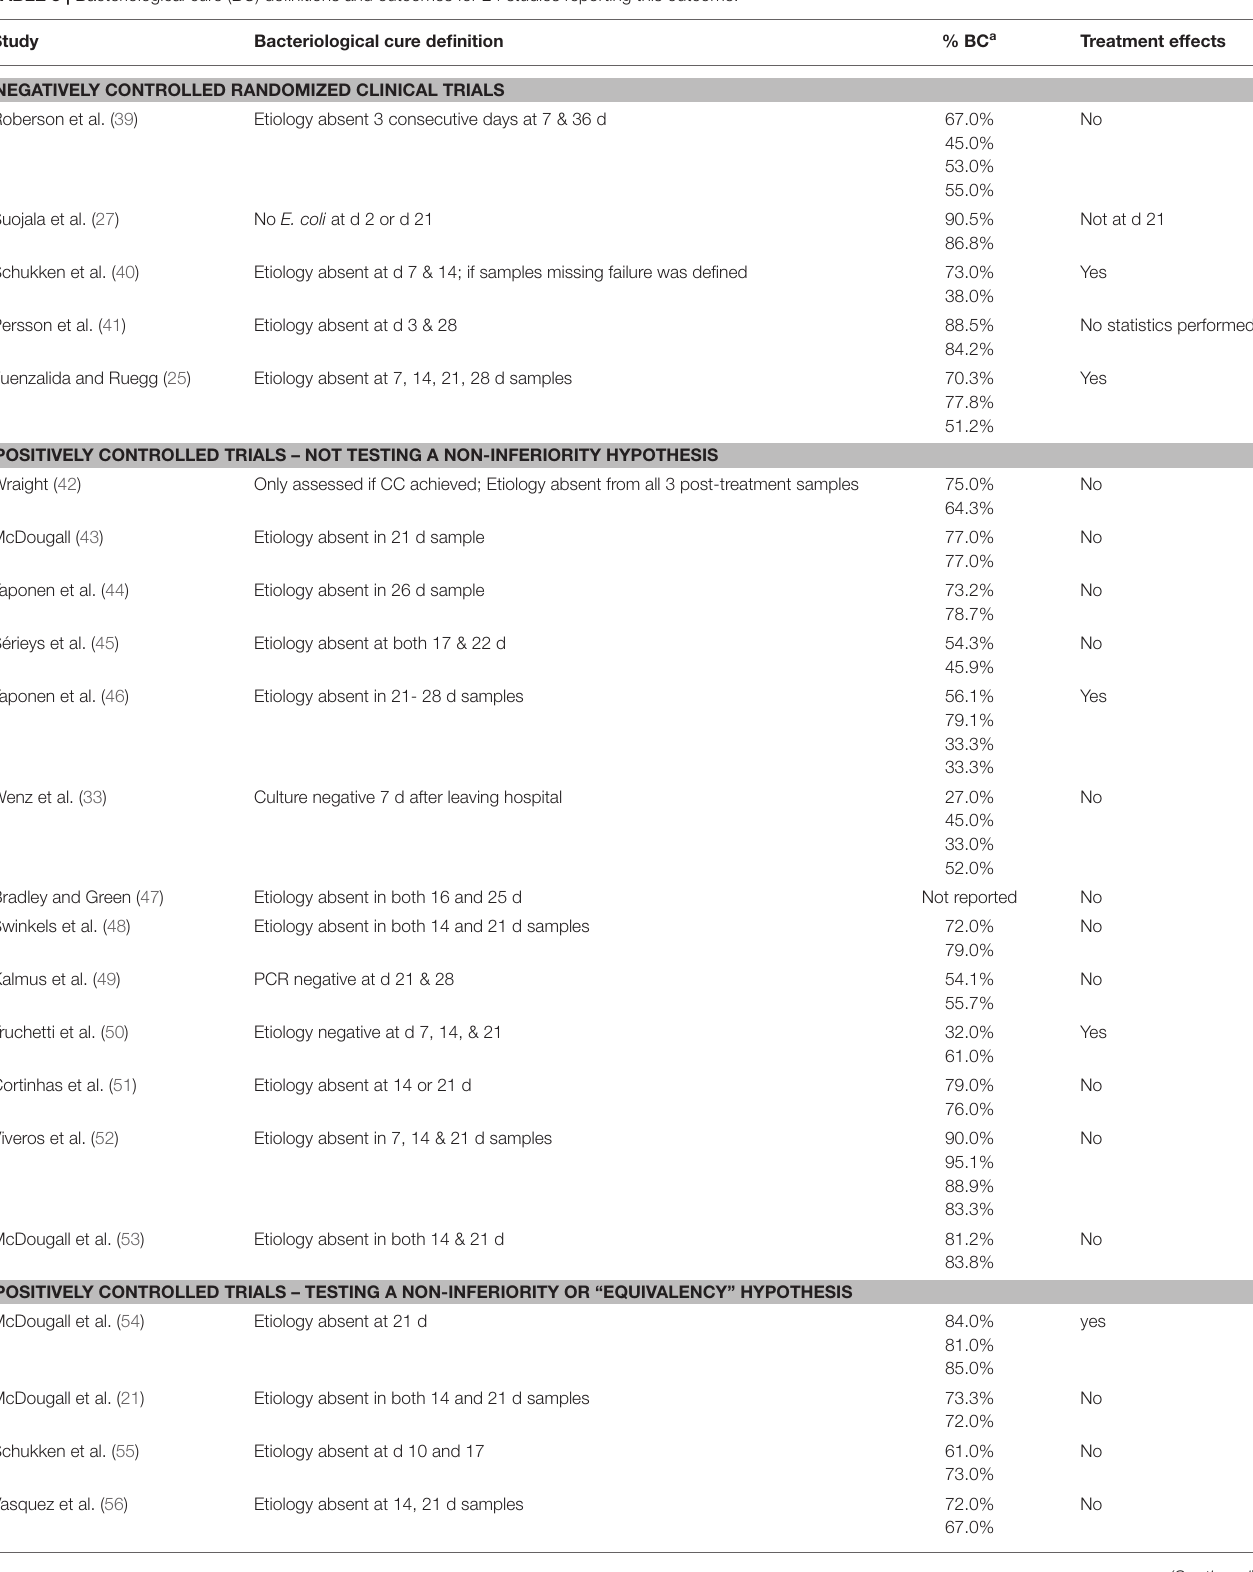
TABLE 3 | Bacteriological cure (BC) definitions and outcomes for 24 studies reporting this